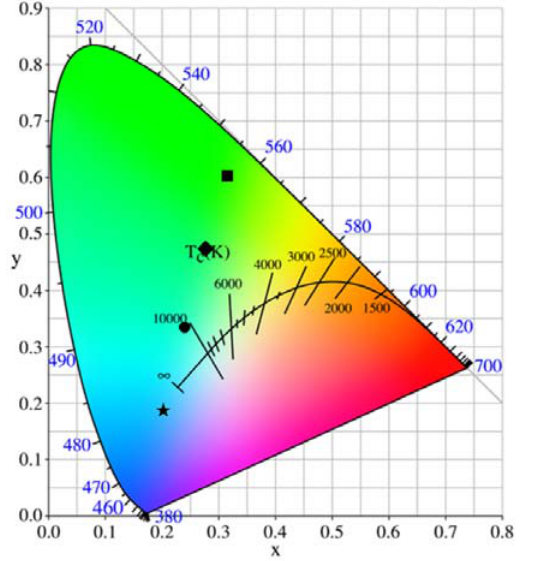
Figure 8. Color temperatures of the β -sialon:Eu 2+ deposits, with various mixed amounts , prepared by the EPD process at 10 s depositing time.  ,  ,  , and  (0–1 g) of the SnO 2 denote 0, 0.05, 0.1, and 1 g of the SnO addition, 2